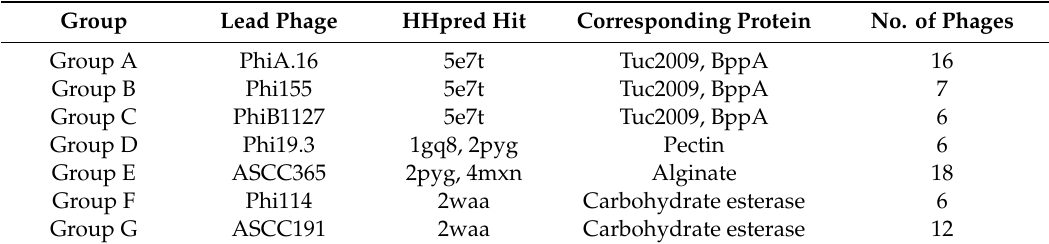
Table 3. Neck passage structure (NPS) classes as determined by HHpred